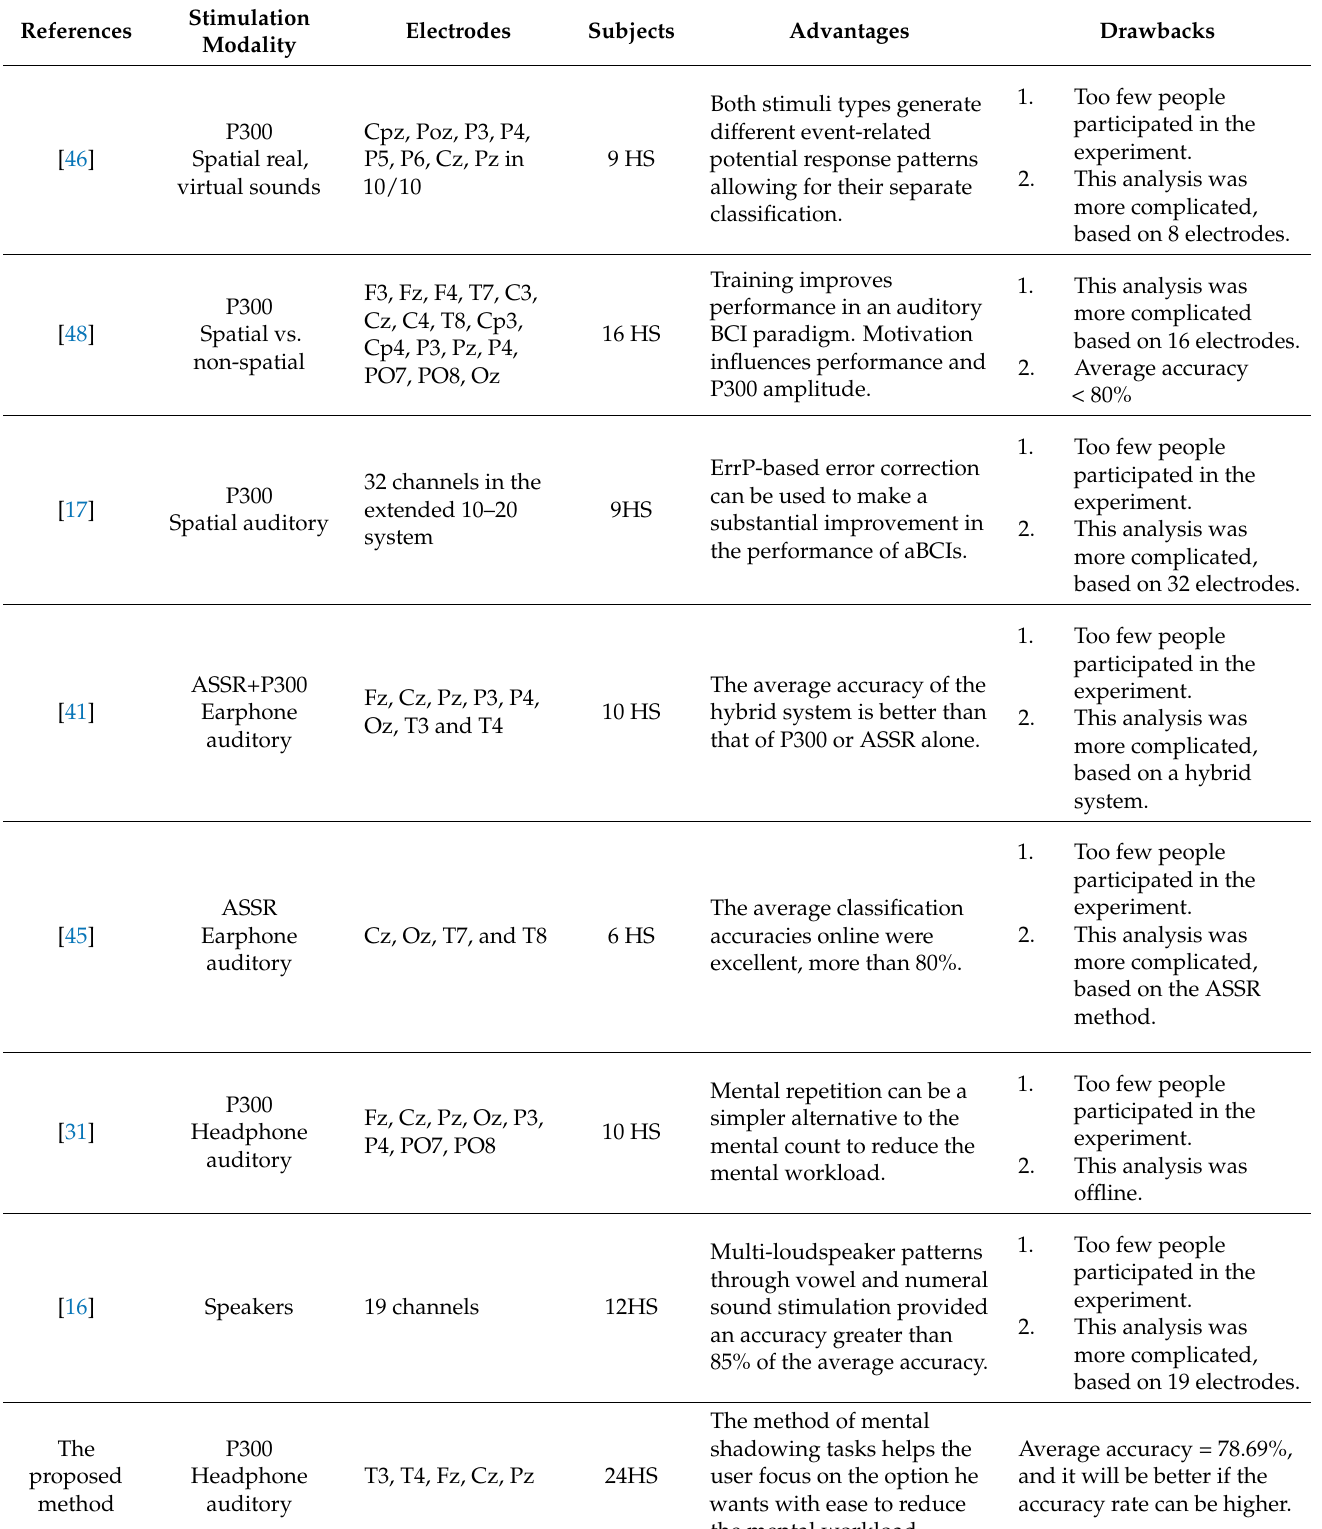
Table 14. A comparison of the advantages and drawbacks of the proposed method with other